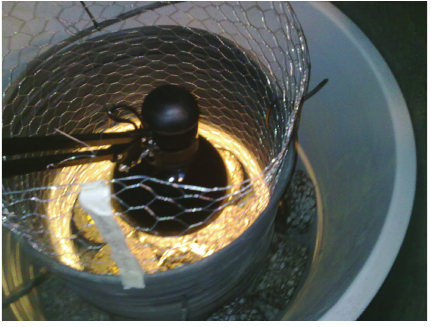
Figure 4: The set-up for